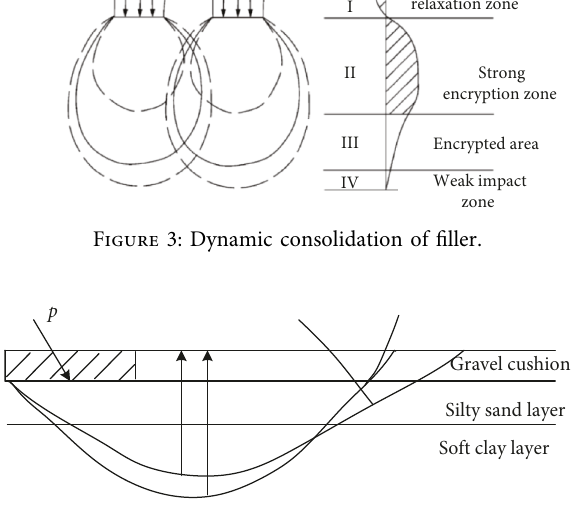
Figure 4: Schematic diagram of the depth of the foundation holding